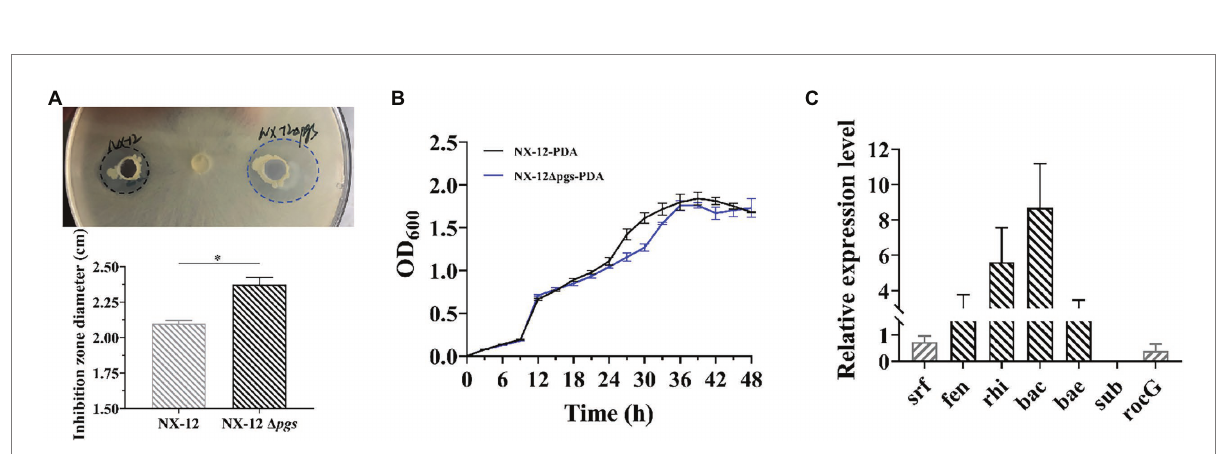
FIGURE 4 Comparison of the transcription levels of genes related to antimicrobial peptide synthesis between NX-12 and NX-12 Δ pgs . (A) Comparison of antibacterial ability of NX-12 and NX-12 Δ pgs against FOC in vitro ; (B) Growth curves of NX-12 and NX-12 Δ pgs in PDB medium; (C) Transcription levels of synthetic genes related to antimicrobial peptides in NX-12 and NX-12 Δ pgs . Error bars represent standard deviations. * indicated value of p <